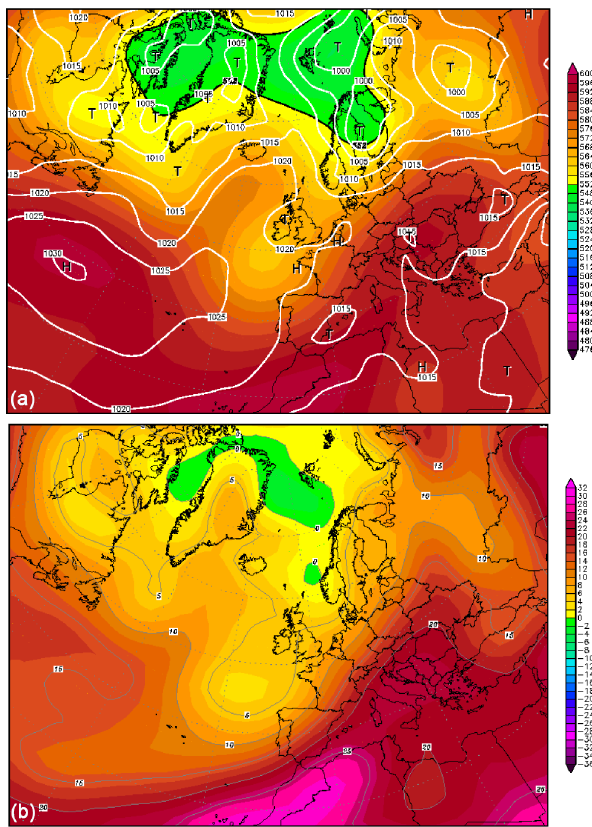
Figure 2. NCEP (National Centers for Environmental Prediction) reanalysis data for 19 July 2007. (a) 500hPa geopotential height (colour scale in m). The white lines mark the surface pressure field (in hPa). (b) Temperature distribution at 850hPa ( ◦